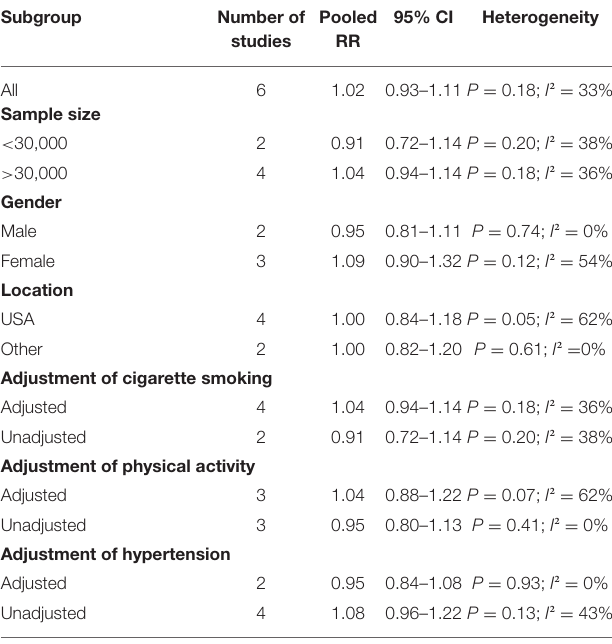
TABLE 2 | Subgroup analyses of fish consumption and the risk of VTE.